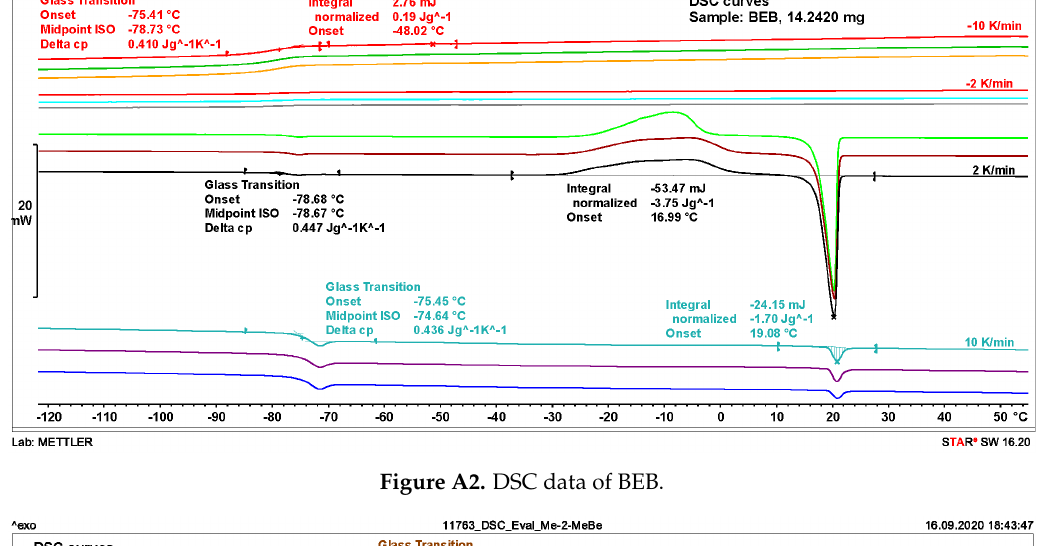
Figure A2. DSC data of BEB.